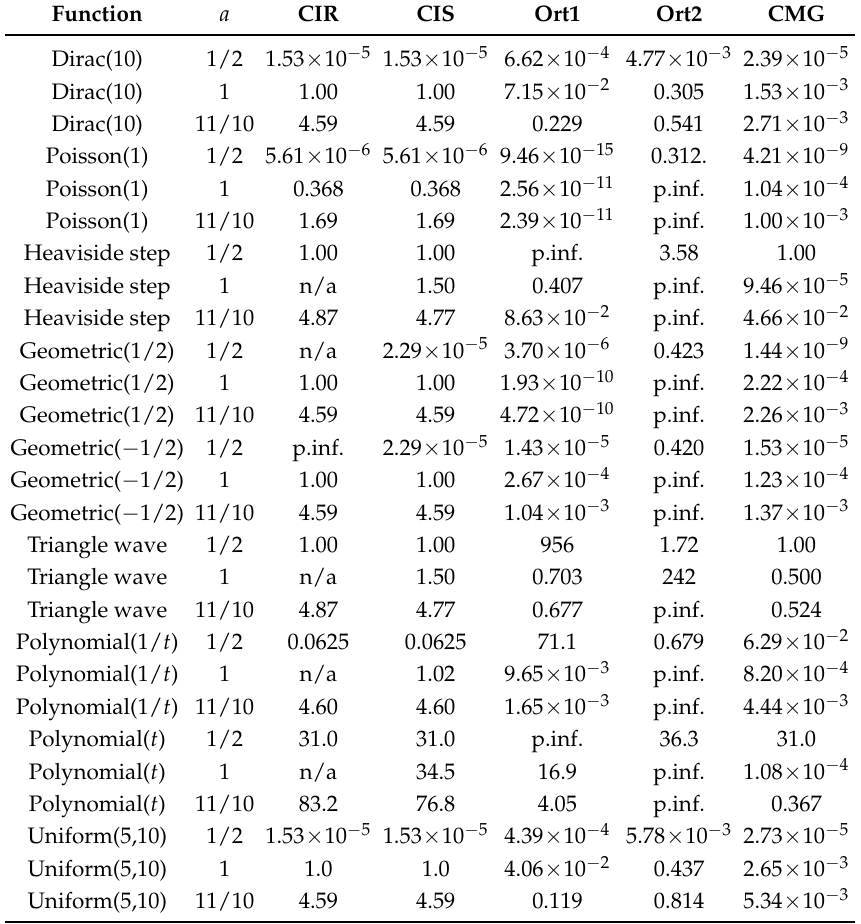
Table 7. Errors for various test functions ( N = 16, T max =